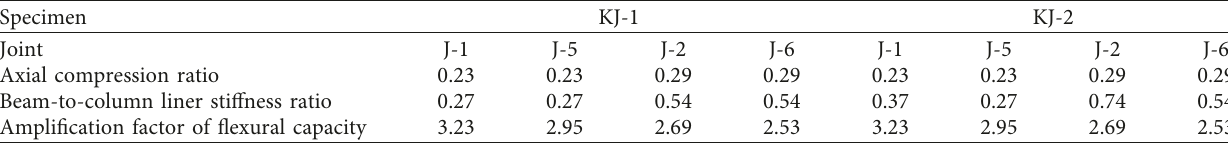
Figure 5: Geometric dimensions and reinforcement details of test specimens. (a) Test setup and reinforcement details of specimen KJ-1. (b) Test setup and reinforcement details of specimen KJ-2. Table 3: Design parameters of test